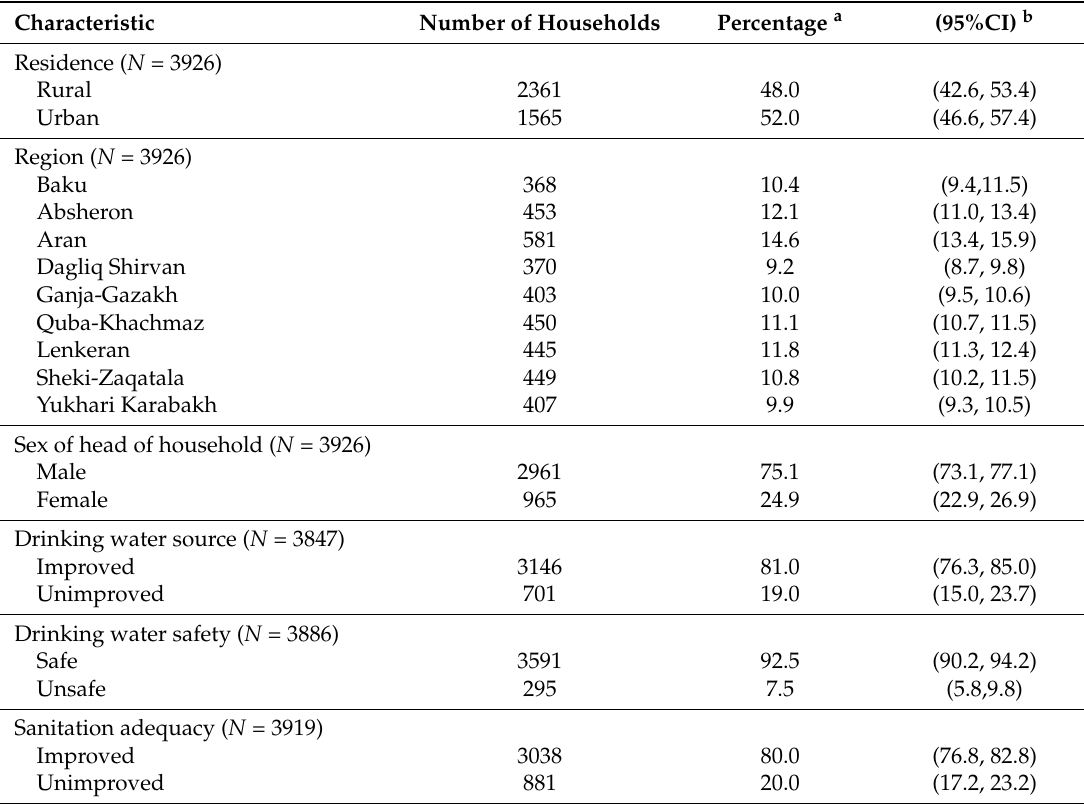
Table 1. Household characteristics, Azerbaijan